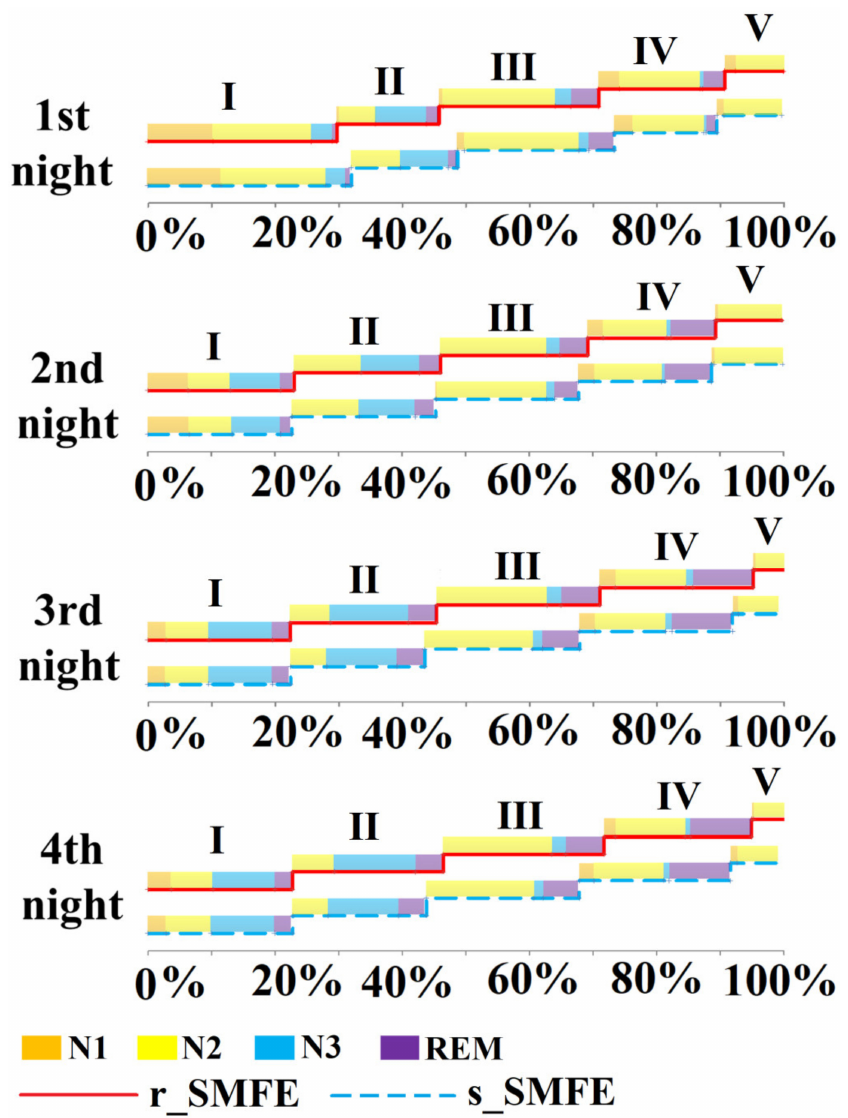
Figure 10. The averaged sleep cycle of the two groups during the four nights. The horizontal axis shows the total sleep duration of the night as 100%, and the graph shows the percentage of each sleep cycle; I~V represents the first cycle to the fifth